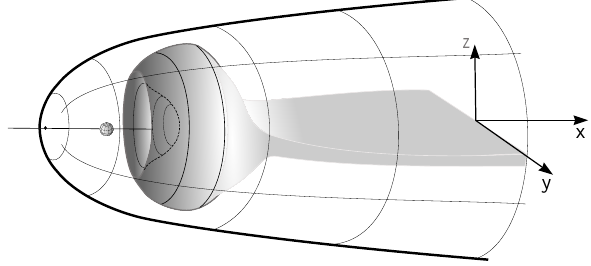
Fig. 1. Model of the magnetosphere. The plasma sheet appears gray. The figure does not show the asymmetry of the near-Earth plasma sheet about the midday-midnight meridian. The outer boundary of the figure is the magnetopause separating the magne- tosphere and the